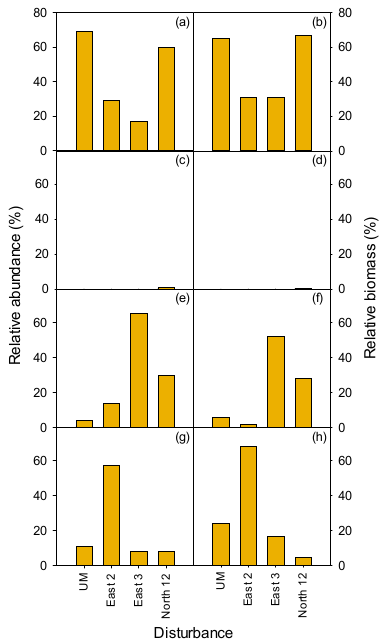
Figure 7. The Menziesia ferruginea (MEFE) habitat type phase 30 years after disturbance and the relative abundance values (%) for seedlings of ( a ) Abies lasiocarpa , ( c ) Larix occidentalis , ( e ) Picea engelmannii , and ( g ) Pseudotsuga menziesii var. glauca , along with their respective relative biomass values (%) ( b , d , f , h ). Note: x-axis values progress from undisturbed forest (left) to the highest severity disturbance (right); see Table 1 for disturbance category descriptions.